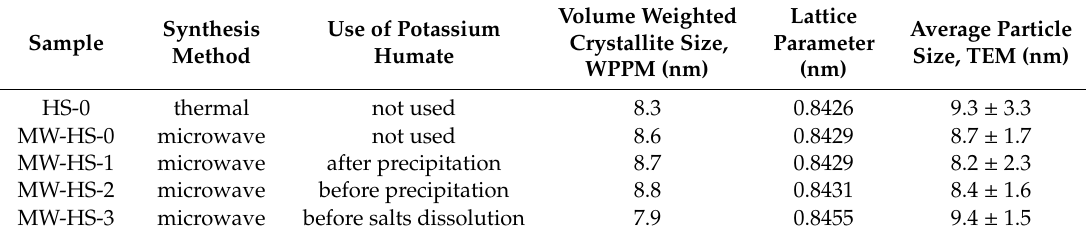
Table 1. Synthesis conditions and structural properties of the samples.